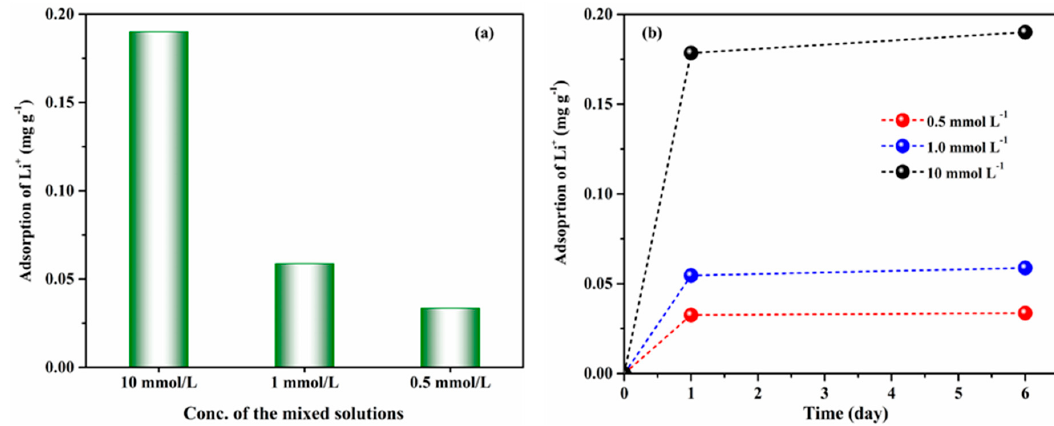
Figure 3. The adsorption property of ZSM-5 for LiCl / MgCl 2 mixed solutions: ( a ) Li + adsorption vs. concentration of solution, ( b ) Li + adsorption vs. time (day),